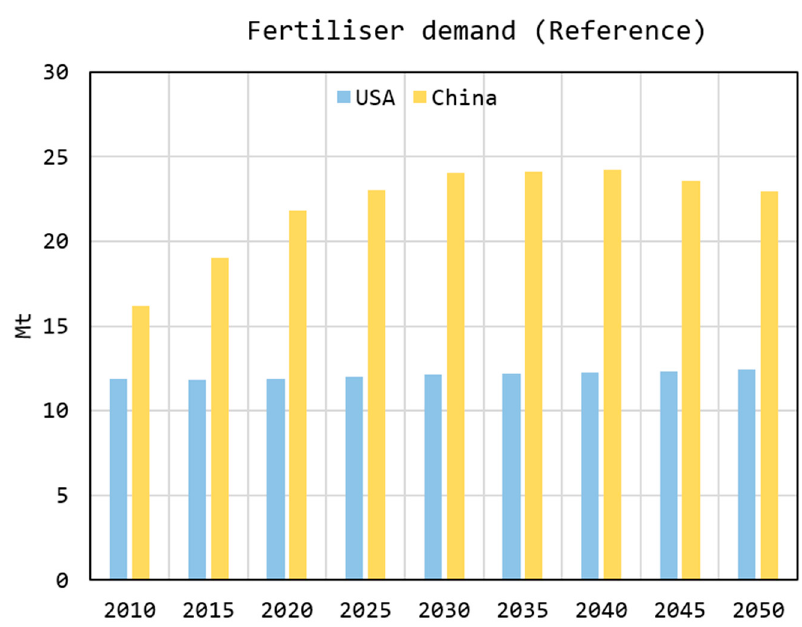
Figure 8. N-based fertiliser demand for both countries in the reference scenario.